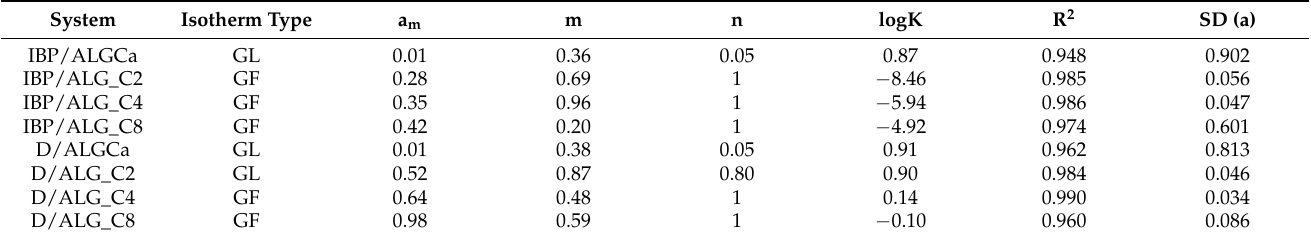
Table 3. Parameters of the generalized Langmuir equation characterizing adsorption of ibuprofen and diclofenac from dilute aqueous solutions on calcium alginate and alginate–carbon composites.